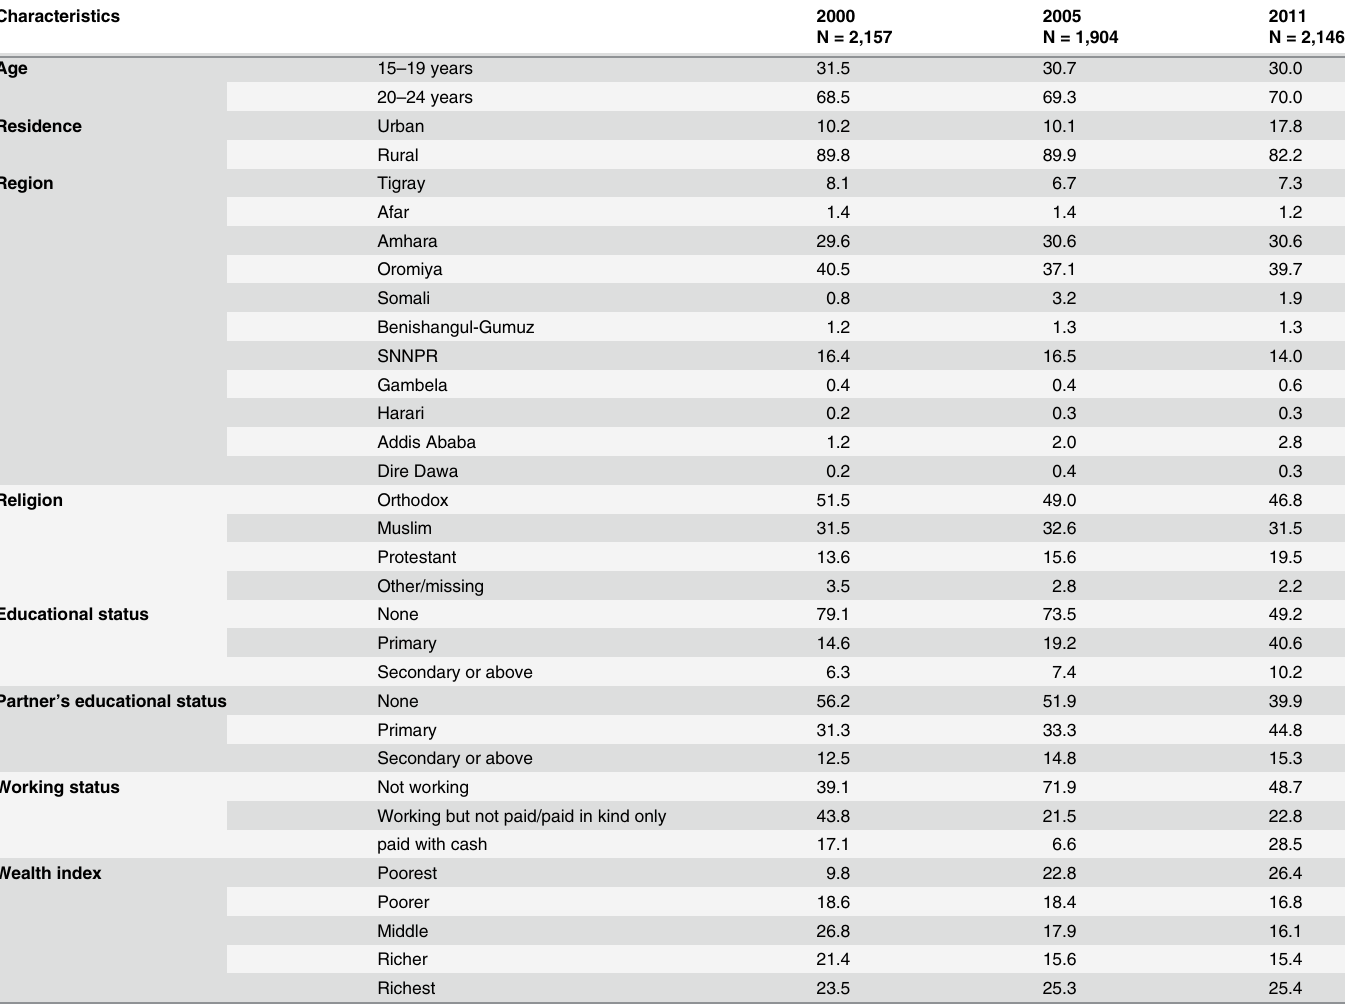
Table 1. Percentage distribution of socio-demographic characteristics of the respondents, 2000, 2005, and 2011 Ethiopia Demographic and Health Surveys.